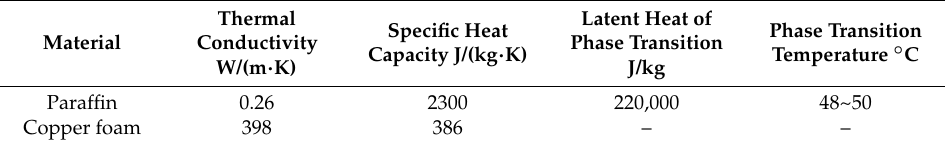
Table 1. Physical parameter of